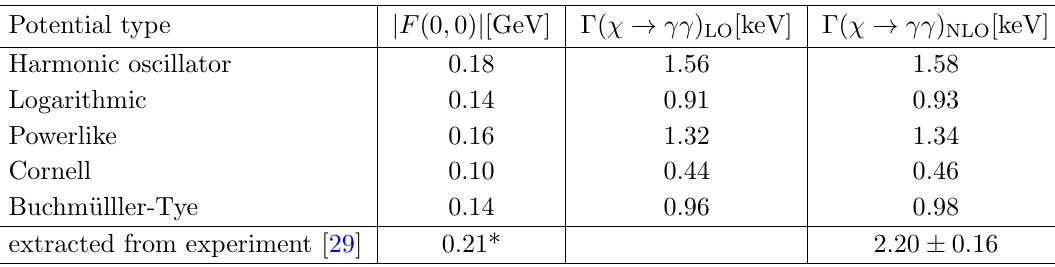
Table 2 . F TT (0 ; 0) and (cid:0)( (cid:31) ! (cid:13)(cid:13) ) for (cid:31) c 0 for (cid:12)ve di(cid:11)erent potentials. The value marked by * is obtained from eq. (4.4), (5.1).